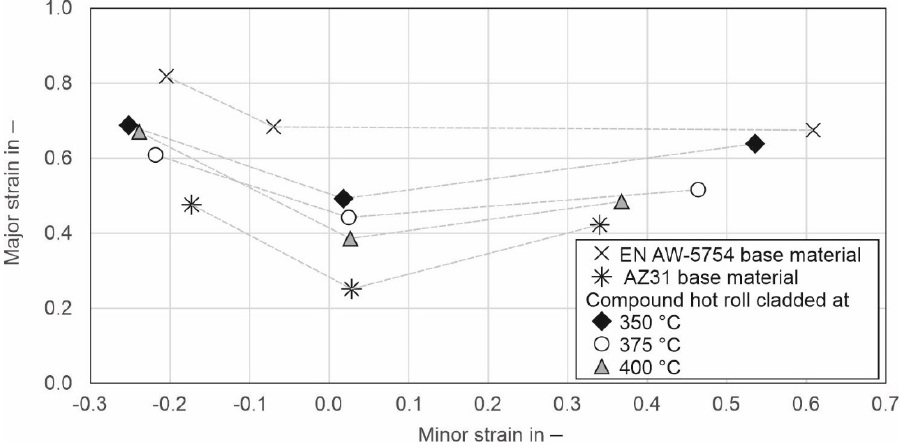
Figure 6. Forming limit curves of base materials and compounds for 300 °C test temperature.